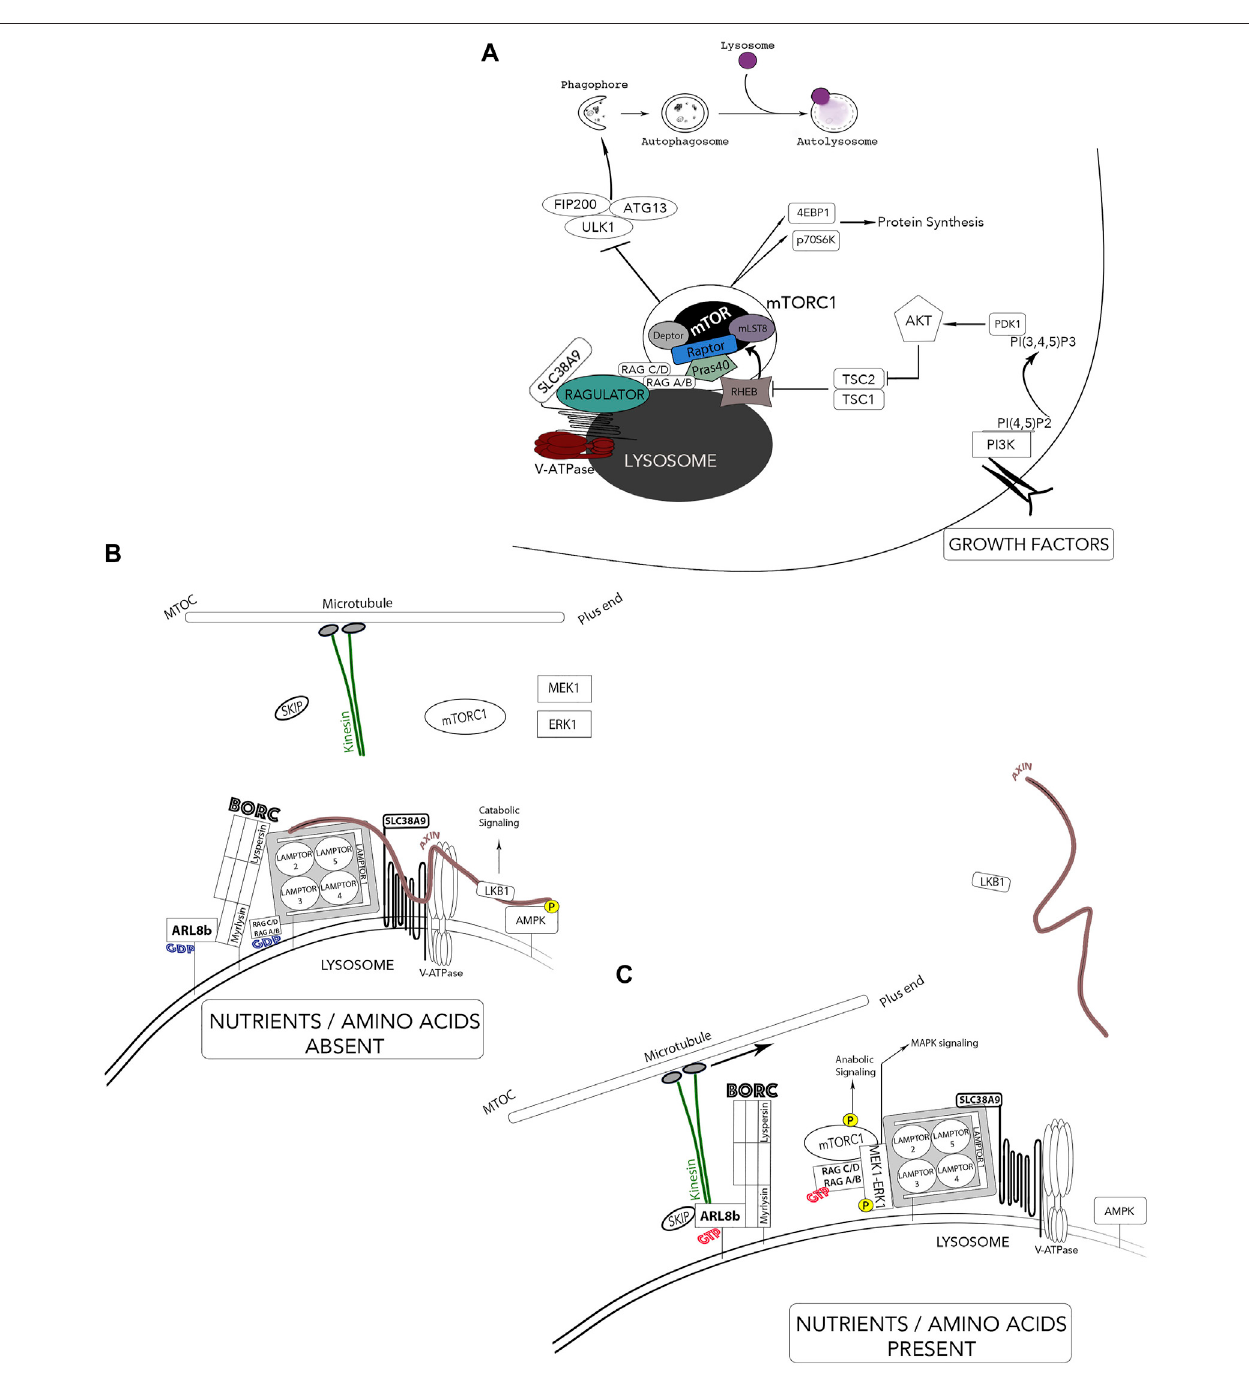
FIGURE 5 | Lysosomes - Nutrient sensors via mTOR and autophagy regulation. The lysosomes receive information from the extracellular environment and generates a signaling response mediated by the activation of mTORC1. Two major independent signals regulate mTOR activity; growth-factor receptors and amino acids. (A) Growth factor receptors activate mTOR through PI3K and AKT pathways and leads to tuberous sclerosis complex (TSC1/2) and Rheb. mTOR is brought in proximityto its activator Rheb byboth the Ragulator complexand RagGTPases in response to elevated amino acid contents. Activated mTORC1phosphorylates S6K and 4EBP1 and activates protein synthesis while inactivating mTORC1 by starvation inhibits anabolic processes and activates autophagy. (B) In the absence of nutrients and amino acids, Ragulator can activate catabolic pathways such as LKB1-AMPK signaling pathway through the scaffold Axin. The population of these lysosomes arethus located in the perinucleararea. (C) In the presence of nutrients and growth factors, the newly identi fi ed BORC complex and Axin dissociate from the Ragulatorcomplexandleadstoinactivationofcatabolicprocesses(AMPK)andanassociationofBORCtothekinesinmotorsthus,increasinganterogrademovementof lysosomes away for the microtubule organizing center (MTOC). *Adaptation of Colaco and Jaattela (2017).